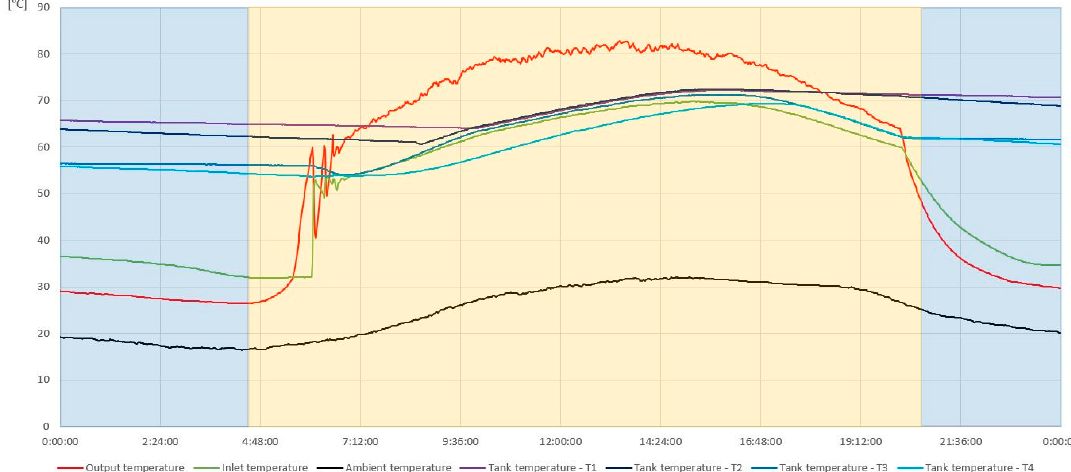
Figure 14. Flow of system inlet and outlet temperatures, outside and storage temperatures during a sunny day.